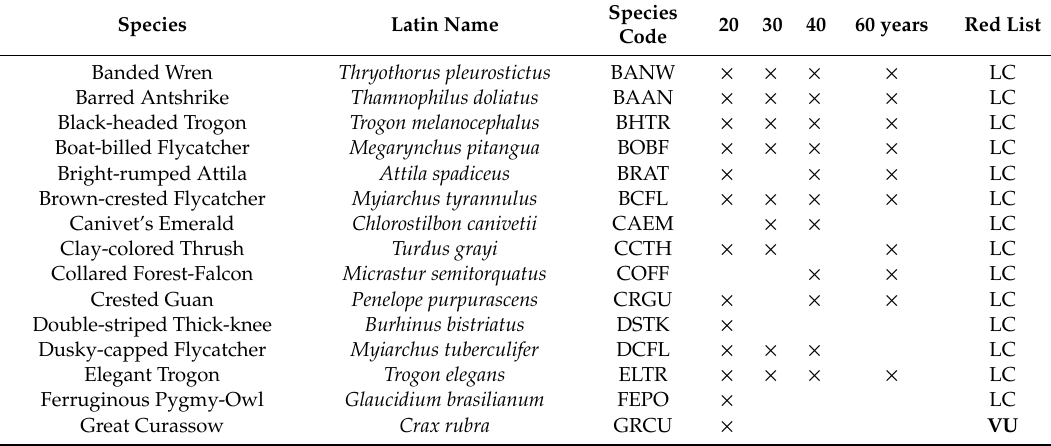
Table 2. Total bird species detected from recordings in all the forest age classes evaluated. IUCN’s Red List conservation categories shown.